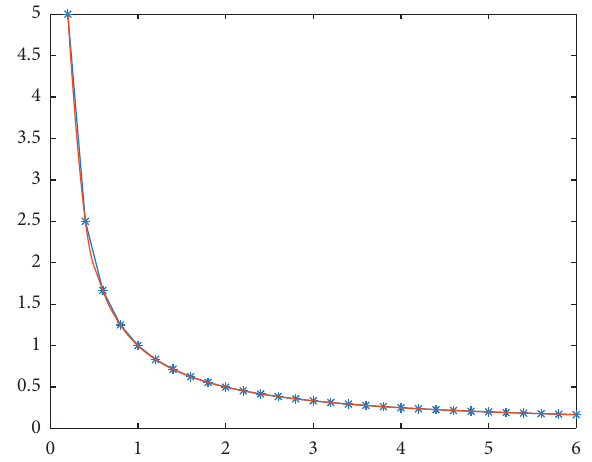
Figure 3: Limit curve by our scheme when lim